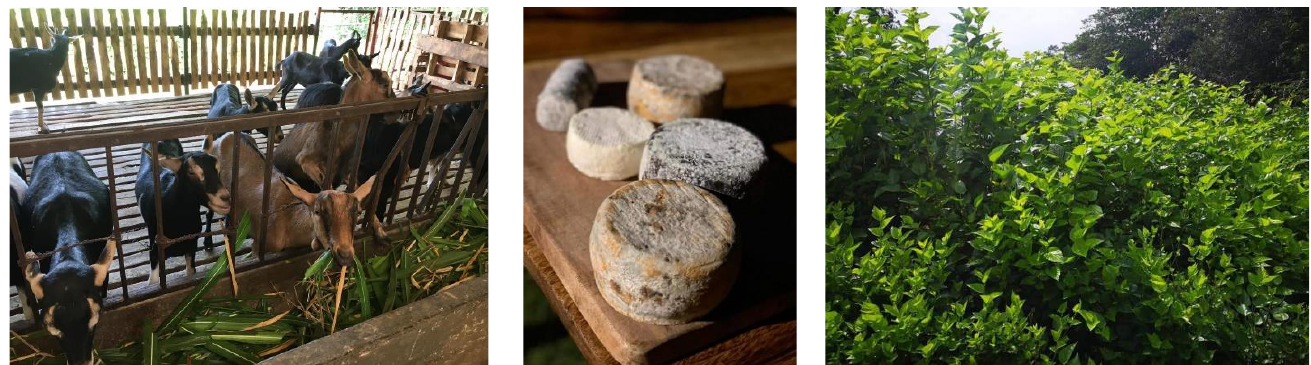
Figure 5. Sustainable farm “Don Nelo” located in eastern Mexico in Veracruz (left). This region is characterized by mountains and subtropical climate. A combination of elements in the system, from diversified production (spreadable and aged cheeses (middle), figs stuffed with cheese, coffee, live animal sales, manure, farm training and gastronomic workshops), agroforestry technologies and agro-ecological practices, to low-cost feed such as Morera (Morus alba ) (right). This system results in higher productivity and profitability for the producer and promotes circular economy at a local level.